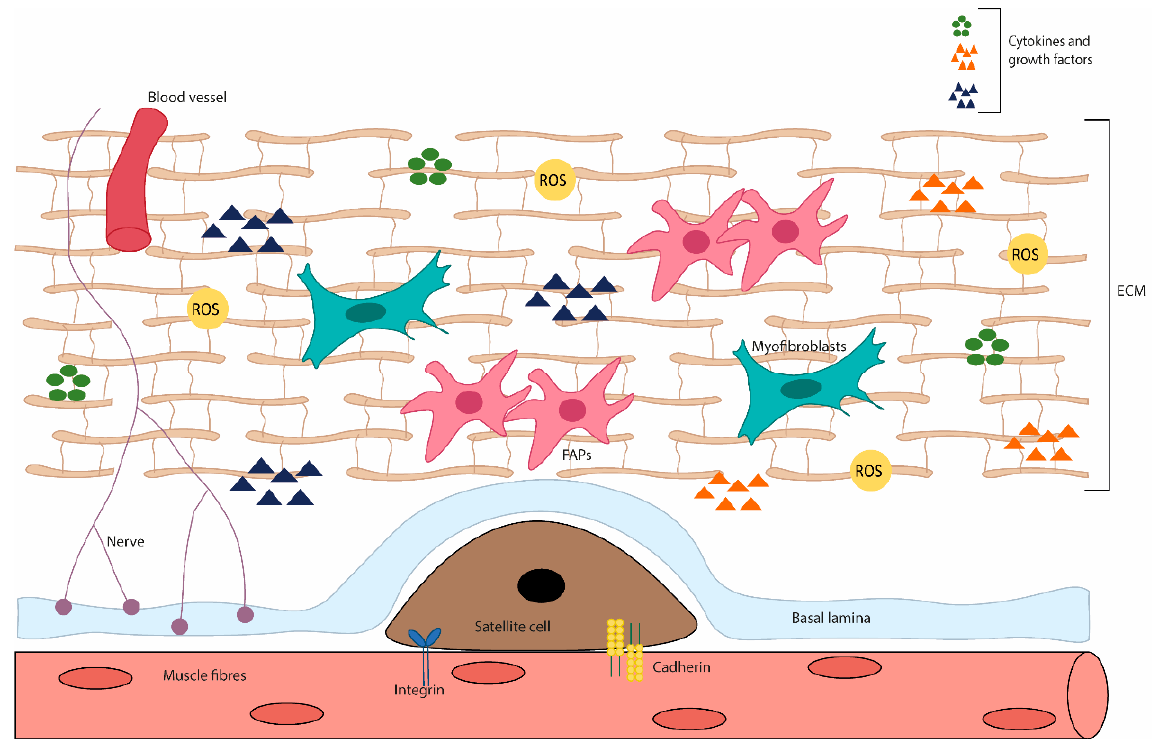
Figure 2. Diagram of the skeletal muscle microenvironment. This niche is composed of various cell types and ECM proteins. In adult skeletal muscle, the quiescent satellite cells stand on the myofiber, under the basal lamina, being surrounded by the ECM, containing blood vessels, nerves, immune cells, fibro-adipogenic progenitors (FAPs), adipocytes and myofibroblast. The satellite cell states are regulated by their interactions with the surrounding microenvironment, direct interaction (e.g., M-cadherin) between muscle fibres and satellite cells; or interact with a variety of components of the ECM and cytokines and growth factors. In addition, stromal cells present can physically interact with satellite cells and release cytokines, growth factors and ECM components, which influence the behaviour of satellite cells, contributing to muscle growth, homeostasis and